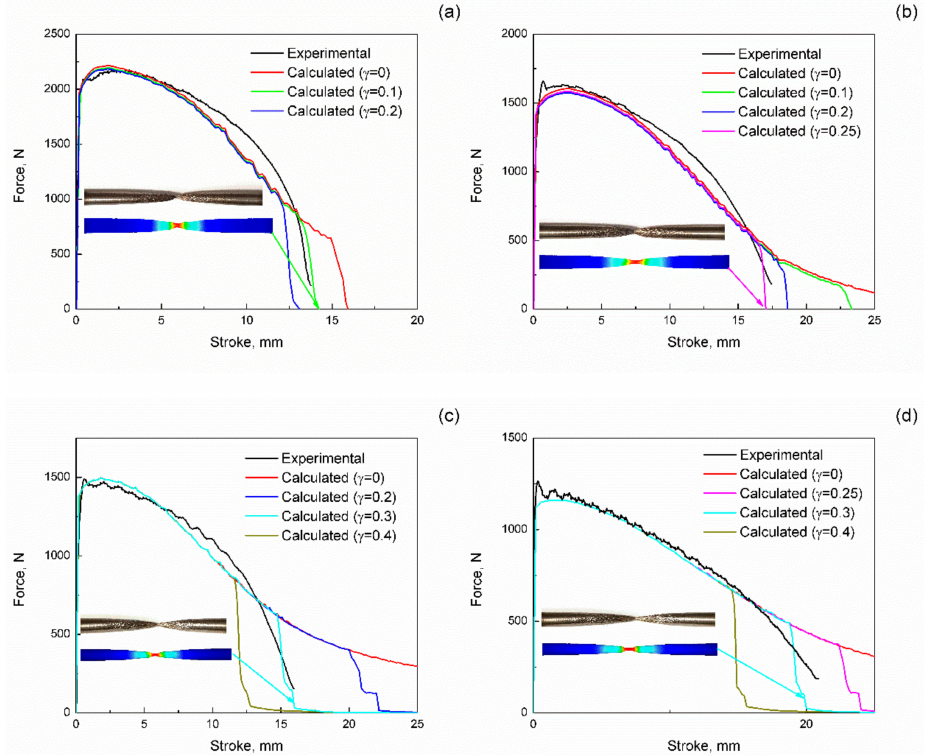
Figure 10. Comparison between experimental and calculated tensile curves at ( a ) 1100, ( b ) 1150, ( c ) 1200 and ( d ) 1250 ◦